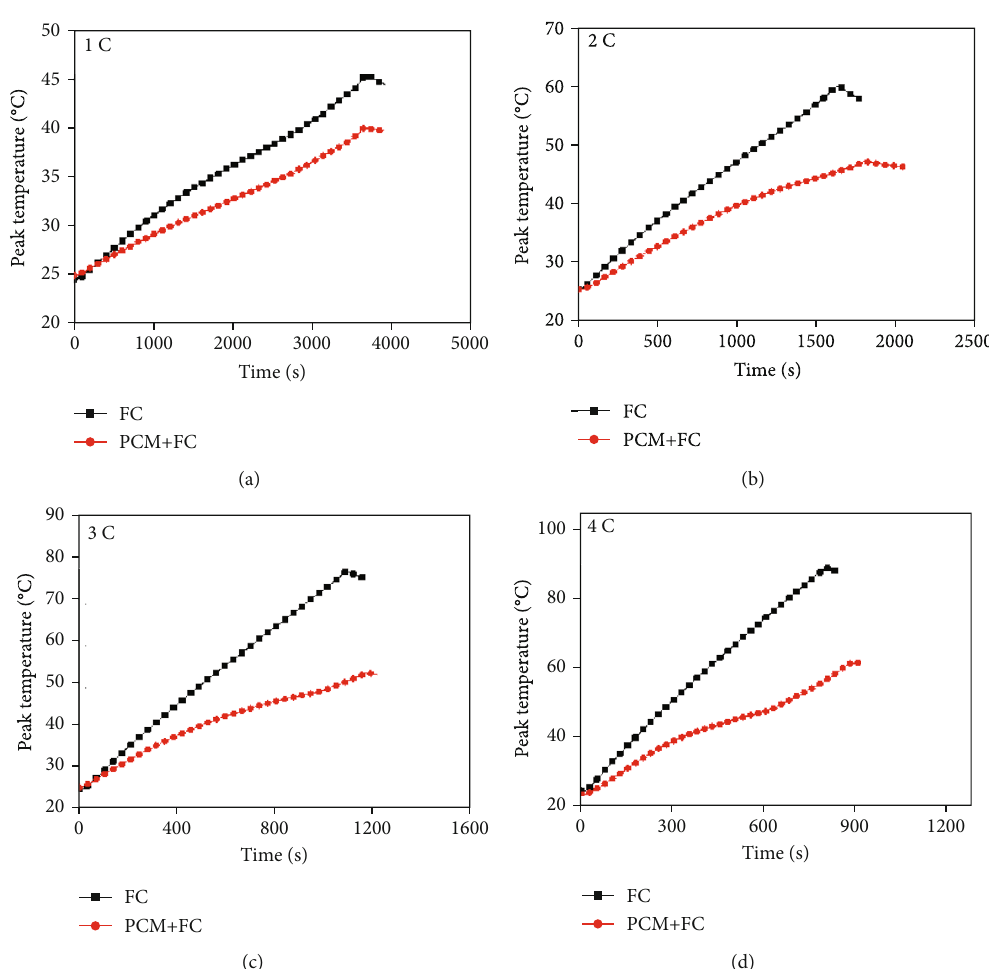
Figure 10: Peak temperature comparisons of the battery modules with the FC cooling system and PCM coupled with the FC cooling system (3 m/s).